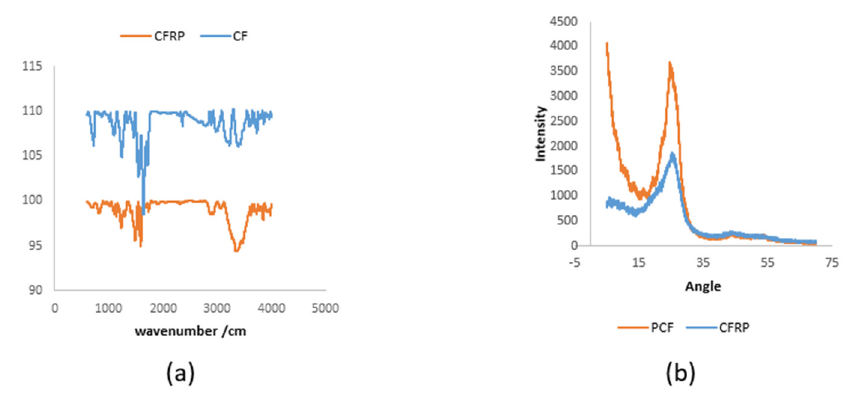
Figure 17. ( a ) FITR spectra of CFRP and CF; ( b ) XRD spectra of CFRP and CF.